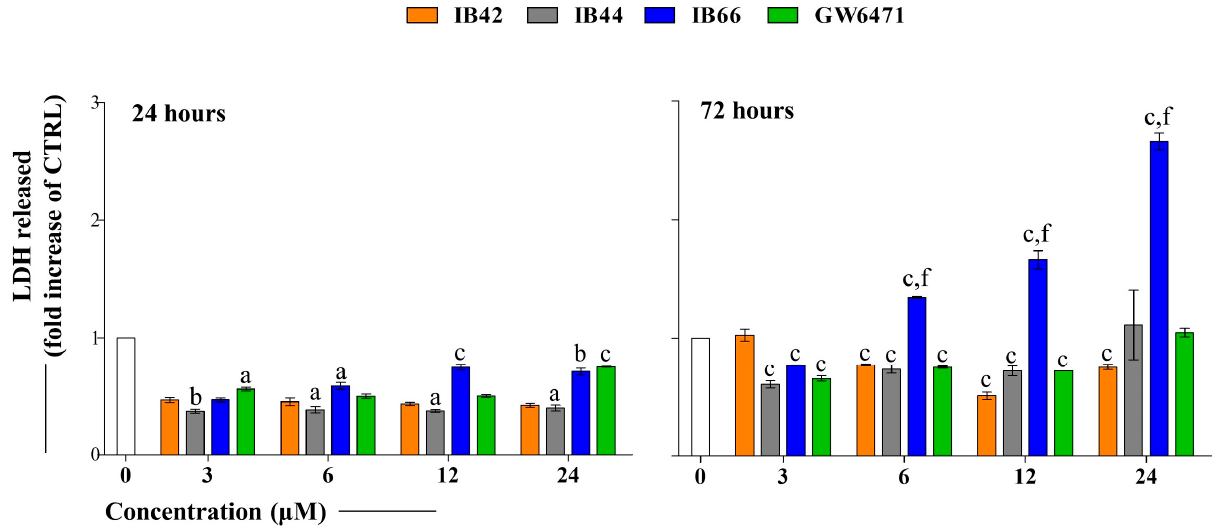
Figure 3. Cytotoxicity occurrence in MCF7 cells in the presence of phenylsulfonimide derivatives. Bar graphs present the LDH released from treated MCF7 cells as the fold increases in the one released from untreated cells after 24 and 72 h of exposure. Bars show mean values ± standard deviations summarized from individual values in independent experiments (n = 6). a ( p < 0.01), b ( p < 0.001), and c ( p < 0.0001) between untreated cultures (0 µ M) and treated samples. f ( p < 0.0001) between GW6471-treated cultures and samples in the presence of phenylsulfonimide derivatives. CTRL = 0 µ M.